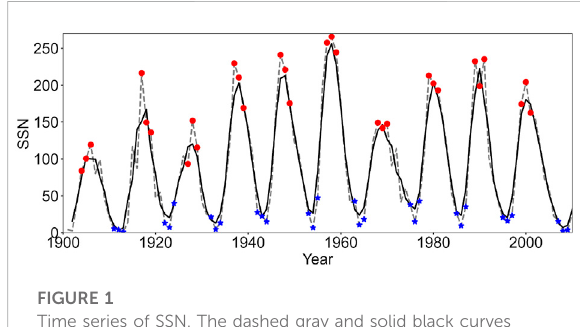
FIGURE 1 Time series of SSN. The dashed gray and solid black curves are the series of JJA SSN and 3-year running mean values of JJA SSN. The red (blue) dots mark the HS (LS)